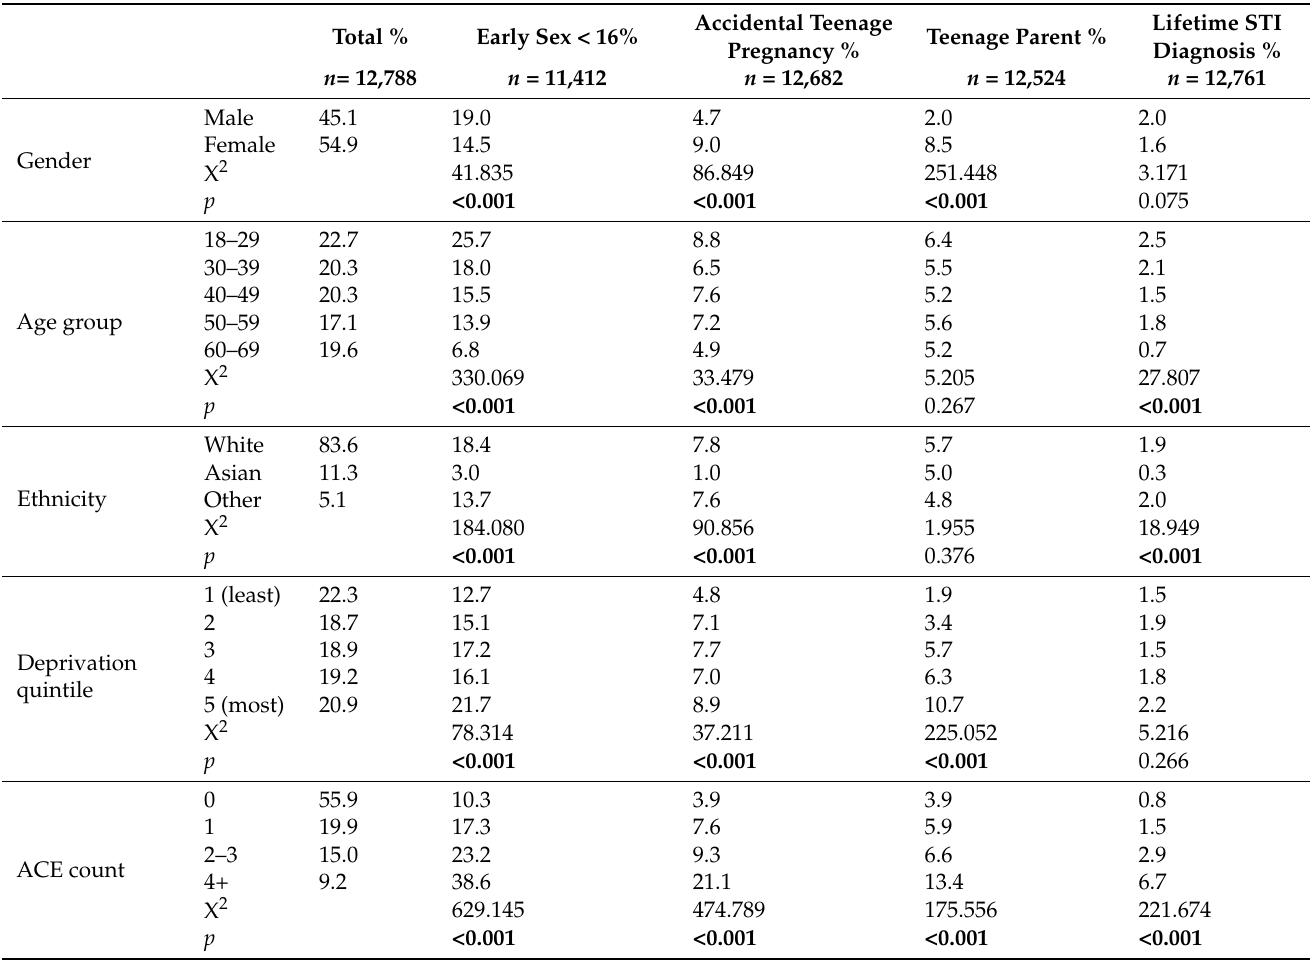
Table 1. Prevalence of sexual health outcomes by participant demographics, ACE count, being born to a teenage mother, and study